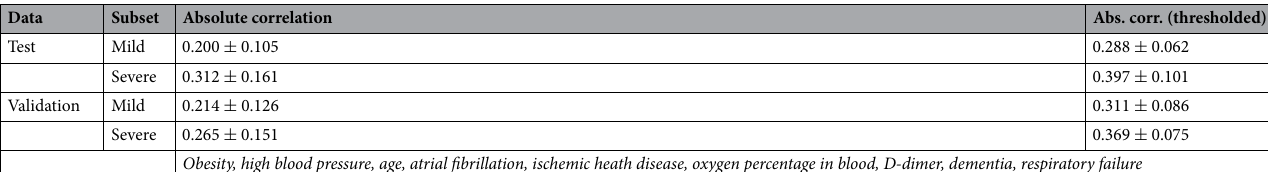
Table 3. The calculated correlation values were thresholded at a 0.2 absolute value in order to remove the less correlating features. The remaining features show above average linear absolute correlation with the Brixia-scores. Correlation variance was significantly reduced after the feature selection. The highly-correlating features are also shown in the table under the absolute correlation